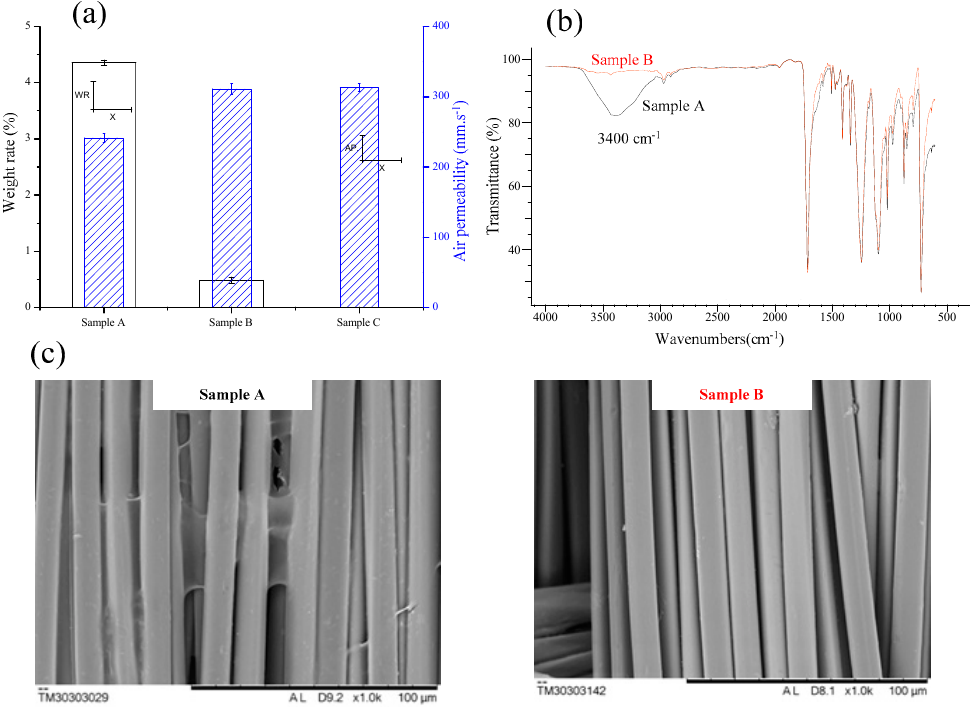
Figure 4. E ff ect of xanthan gum of treated PET fibers. ( a ) Change of weight ratio and air permeability of fibers. ( b ) Fourier transform infrared spectroscopy (FTIR) spectrum of fibers. ( c ) Scanning electron microscopy (SEM) image of fibers ( × 1000). Sample A was PET fibers treated using CaCl 2 and xanthan gum. Sample B was PET fibers treated by post-treatment. Sample C was untreated PET fibers.